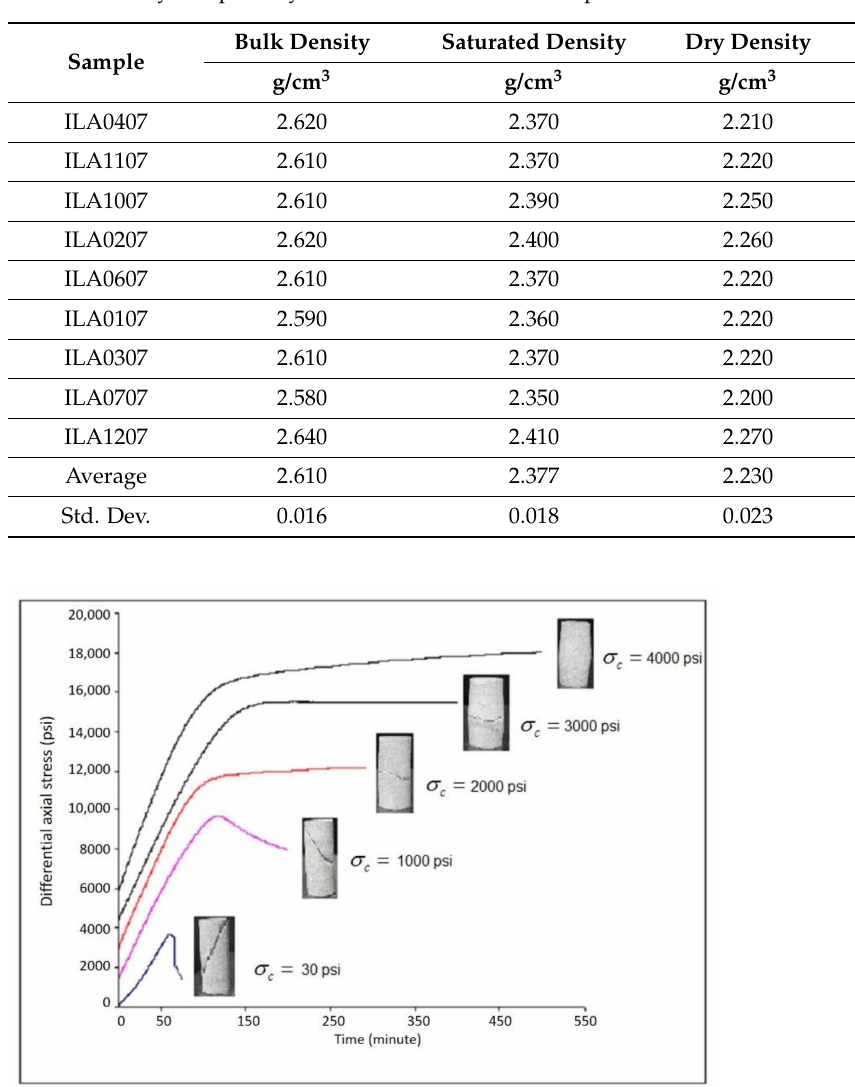
Figure 5. Failure modes of Indiana limestone under different confining pressure*, σ c , at room temperature with constant axial compressive strain rate. (*Note: Confining pressures marked next to the fractured samples are accurate. Initial portions of the axial stress-time curves at high confining pressures were modified in reassembling all the curves into one